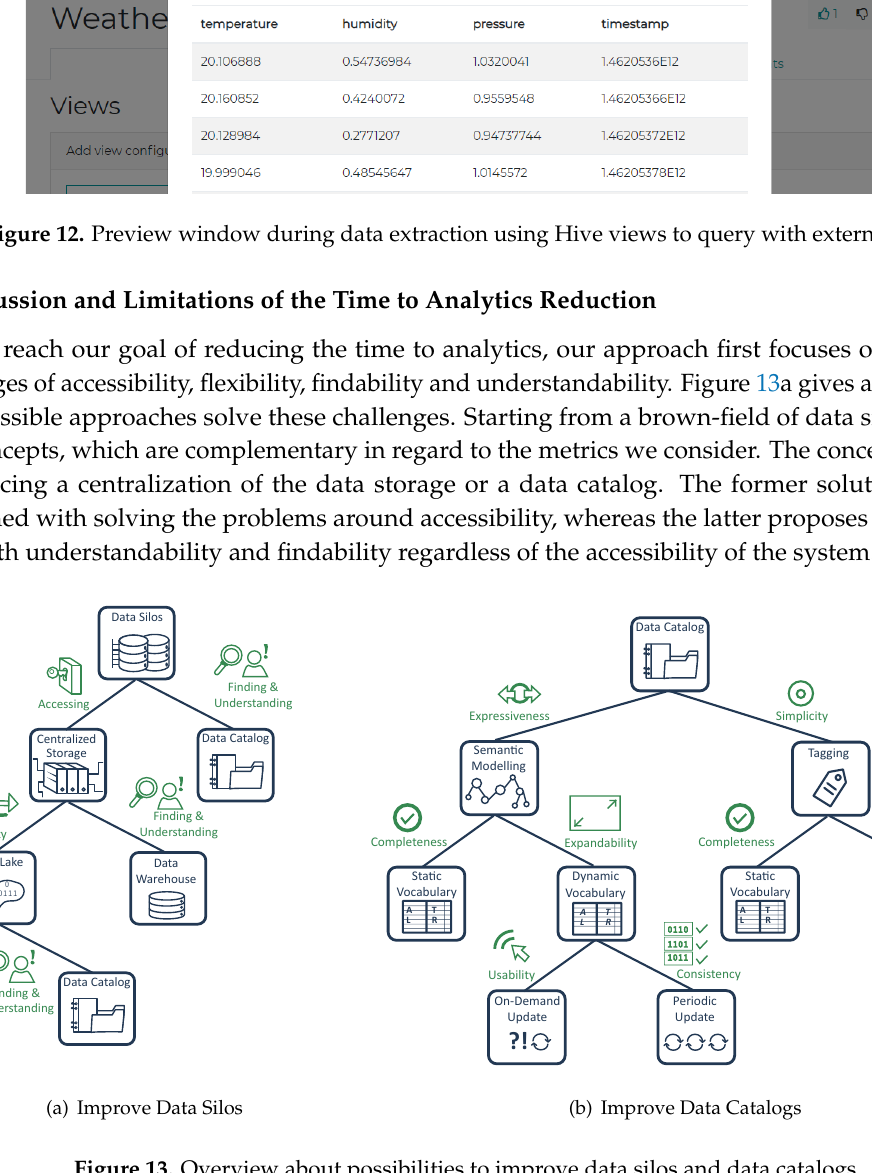
Figure 13. Overview about possibilities to improve data silos and data catalogs.